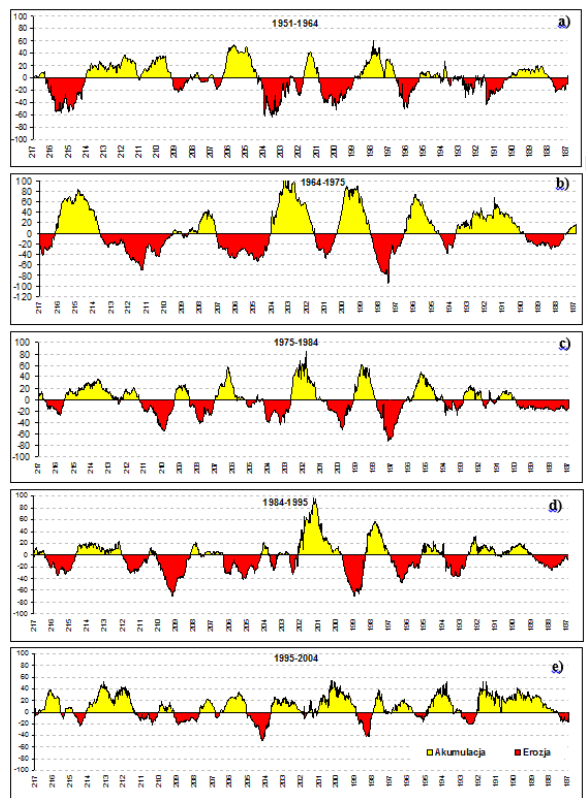
Figure 2. Changes in location of dune base lines in particular time intervals (Y-axis shows dune baseline relocations in [m]; X-axis shows coast kilometre marker points).